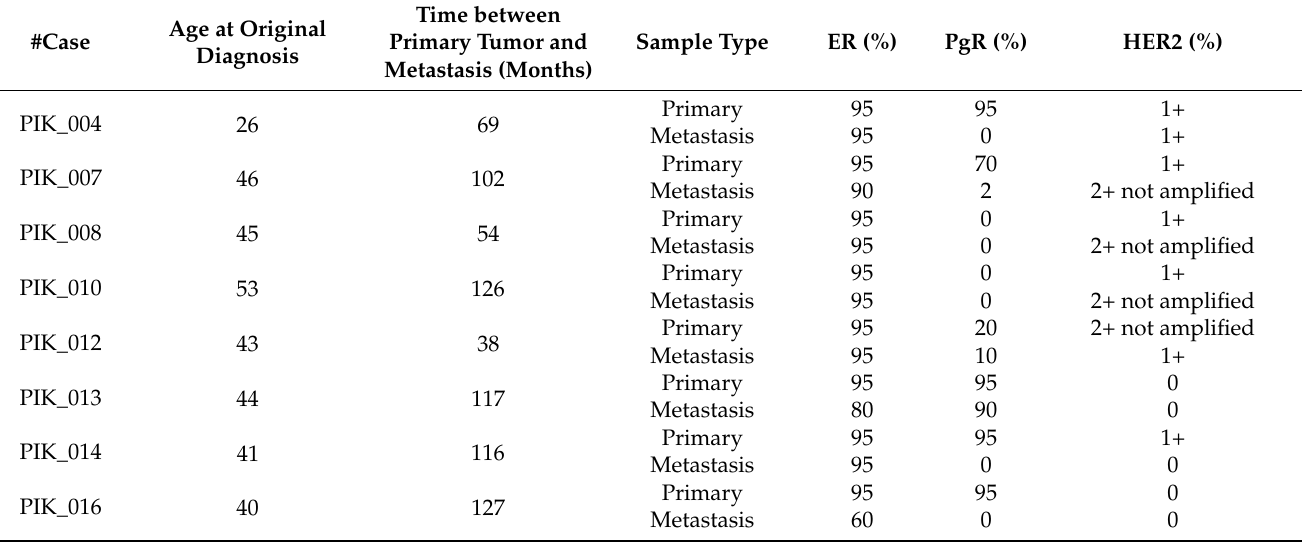
Table 2. Clinicopathological features at a single-case level and time interval between primary tumor and metastasis of the patients with both samples available. All cases were of no special histological